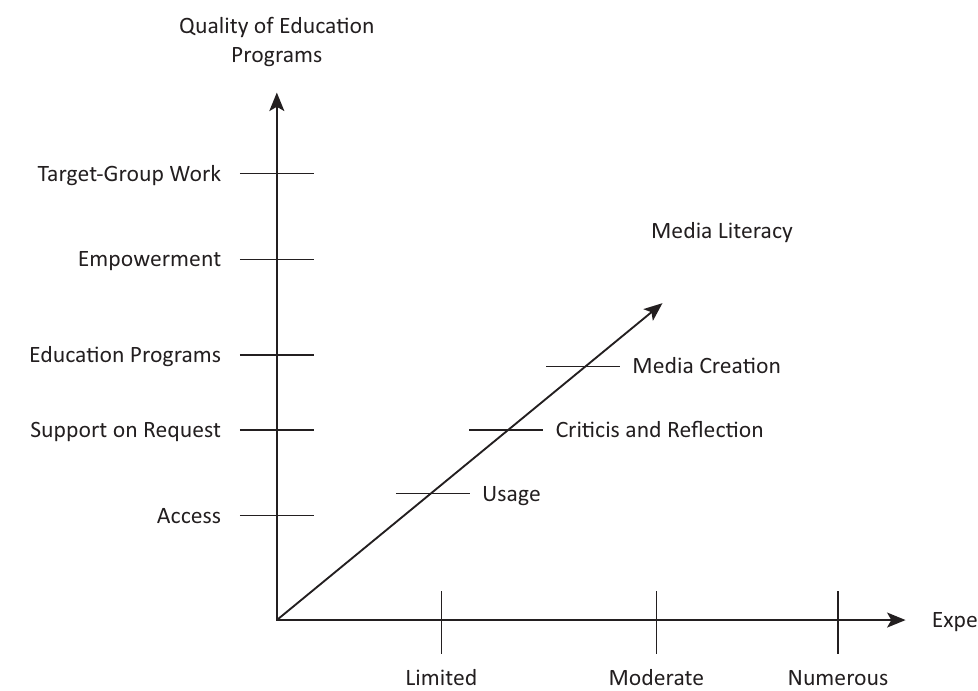
Figure 1. Three levels of analysis for the design of education programs. clusive cooperation (e.g., working in tandems), as Zaynel (interview, 6 August 2019) stated, provides a high level of quality. Here it is important to take pedagogical and didactic methods into account. A flexible workshop struc- ture with different modules, as described by Möser, or using the UDL as a basic method for designing the con- tent should be considered to meet the different learning needs of the